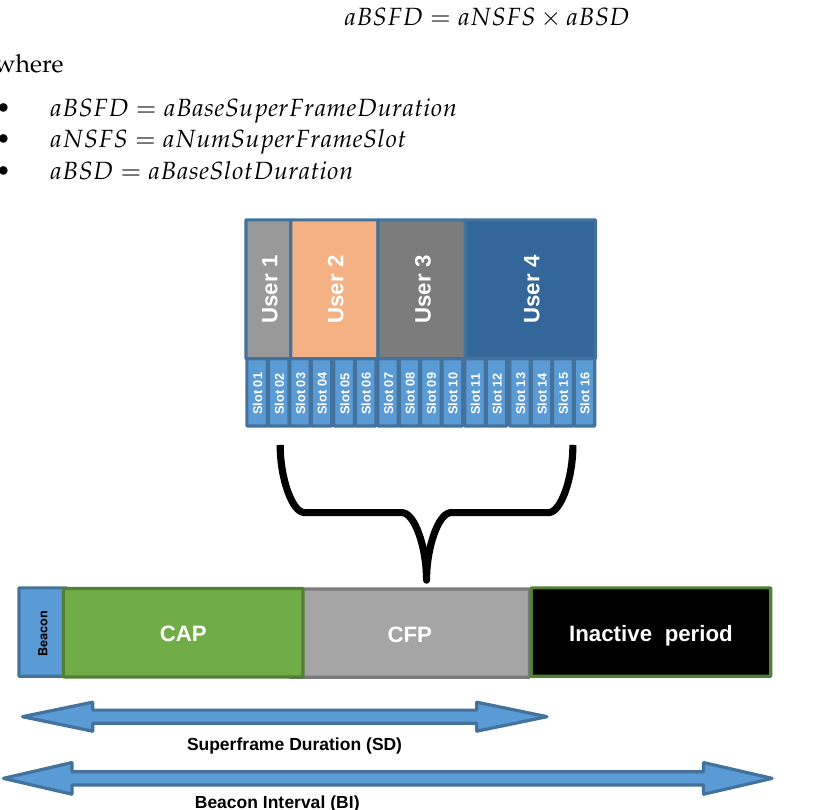
Figure 1. Superframe structure in the IEEE 802.15.7